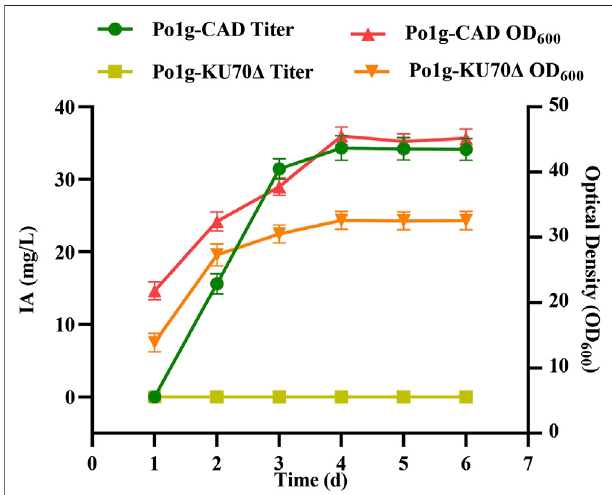
FIGURE 2 | IA production in Y. lipolytica strains expressing the CAD gene. The titer of IA and biomass of Y. lipolytica were determined by shaking fl ask fermentation of Po1g-CAD strain and control strain Po1g in YPO culture. All values presented are the mean of three biological replicates ± standard